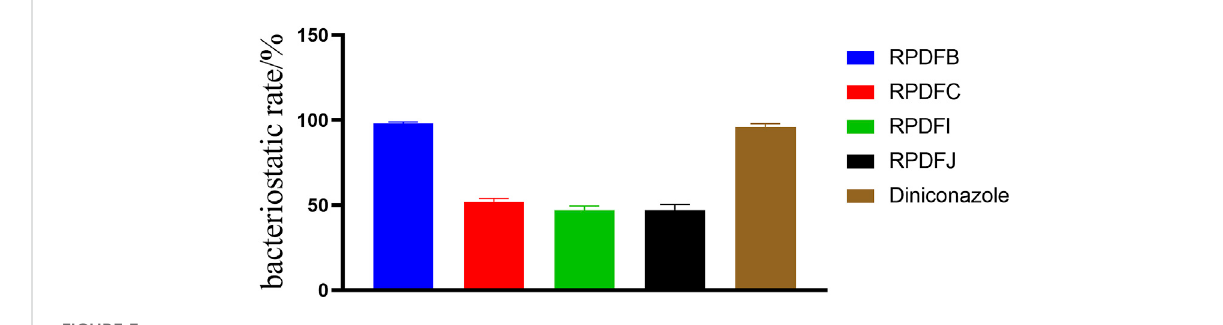
FIGURE 3 Antifungal activity of (E)-2-aroyl-4-arylidene-5-oxotetrahydrofuran derivatives, against- Gibberella zeae .